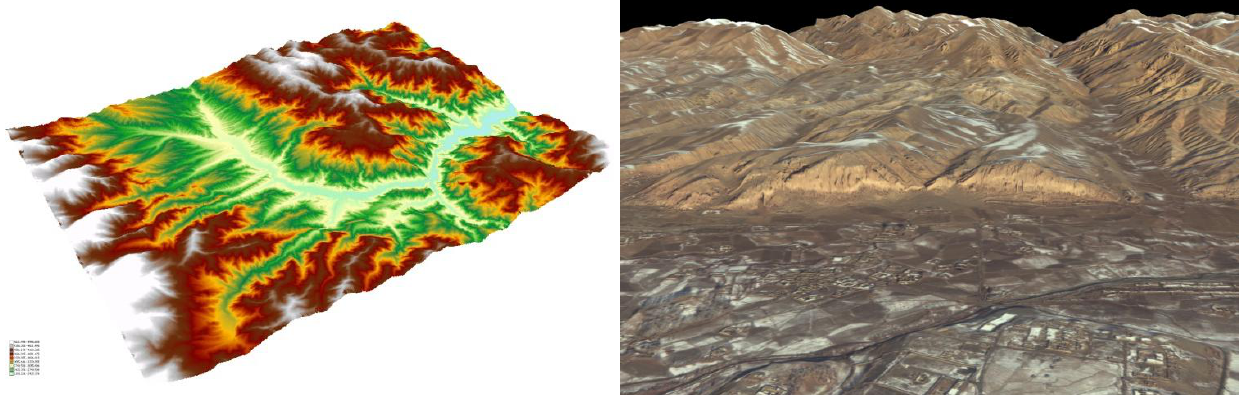
Figure 4. DSM generation from SPOT-5 HRG (left) and textured digital model with a PAN IKONOS image mosaic (right) over the Bamiyan area, Afghanistan